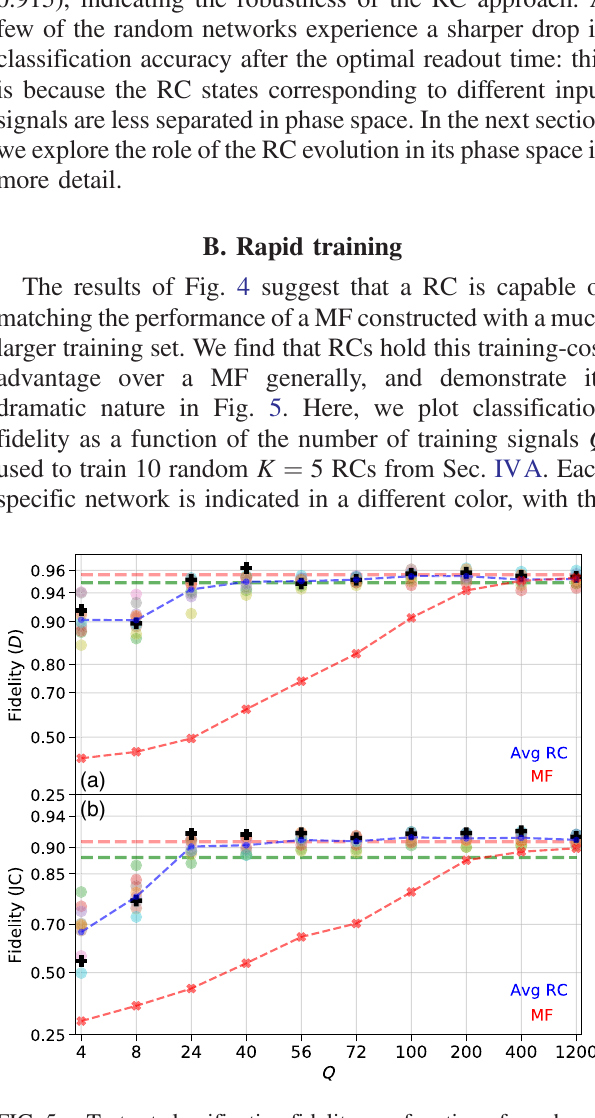
FIG. 5. Test set classification fidelity as a function of number of training trajectories for the MF and K ¼ 5 RCs described in the text. The dispersive and JC readout systems are in (a) and (b), respectively. Individual RCs are indicated with different colored circles, and the RC of Fig. 3 is emphasized with a black plus. The average RC fidelity is indicated with a dashed blue line, and can be compared with the MF performance, denoted with red crosses and a dashed line. The ( Q -independent) performance of the BF and analytic MFs are denoted with horizontal dashed green and pale red lines,